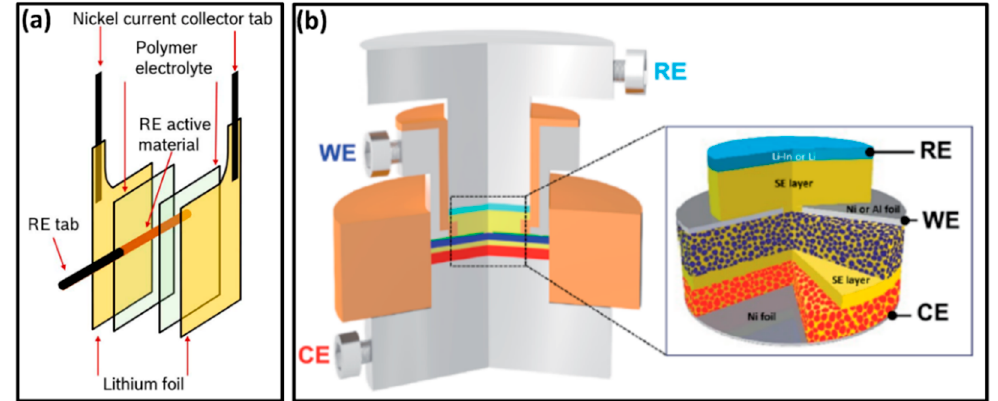
Figure 19. Schematic representation of a lithium/lithium symmetric cell ( a ) all-solid-state Li-ion cell, ( b ) each equipped with an RE. Reproduced with permission from [103,173].